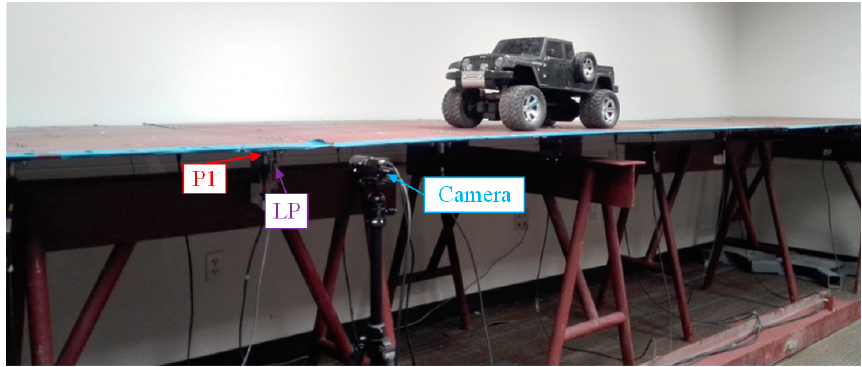
Figure 5. Experimental setup.